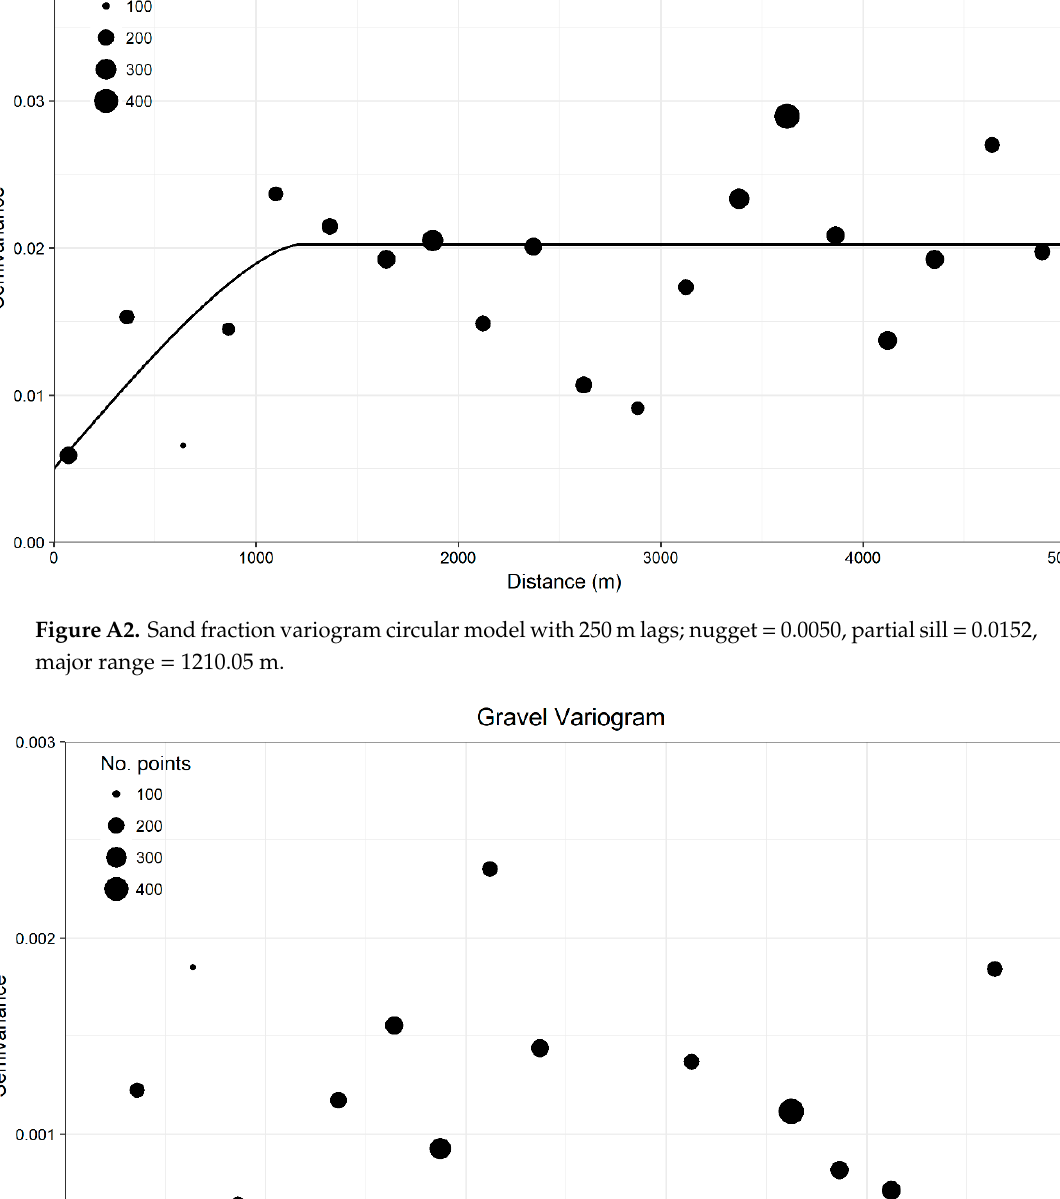
Figure A1. Mud fraction variogram circular model with 250 m lags; nugget = 0.0069, partial sill = 0.0162, major range = 1496.63 m.